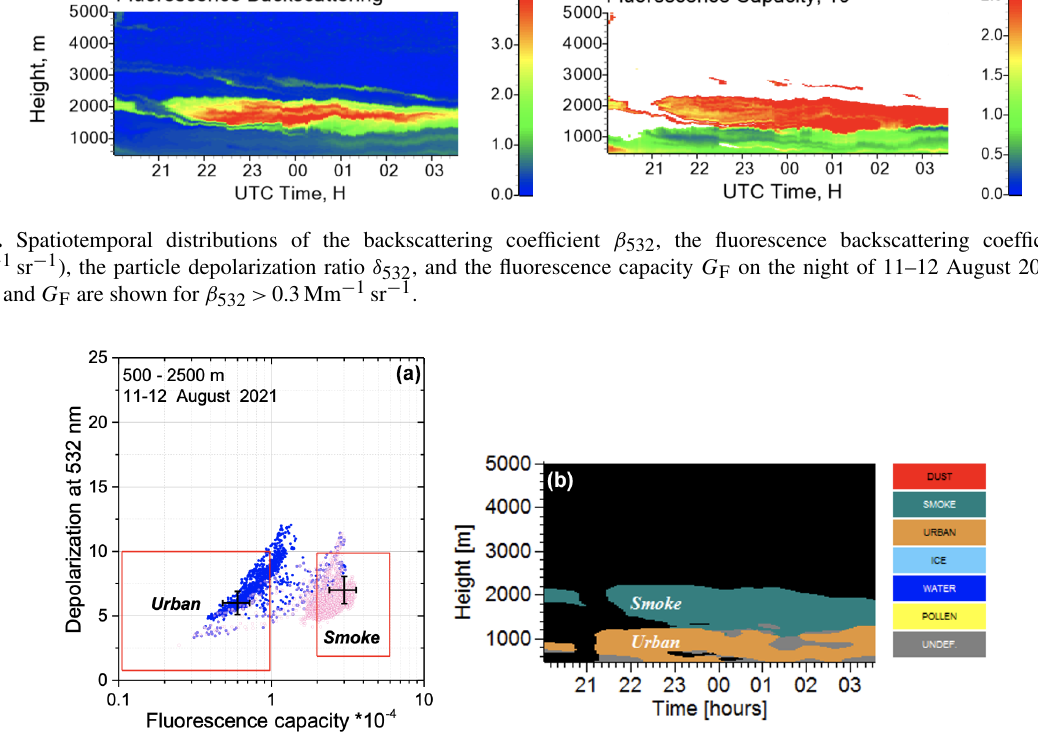
Figure 15. (a) The δ 532 - G F diagram for observations in the 500–1400m (blue symbols) and 1400–2500m (pink symbols) height ranges. (b) Spatiotemporal distribution of aerosol types on the night of 11–12 August 2021. Measurements with β 532 < 0.3Mm − 1 sr − 1 are marked in